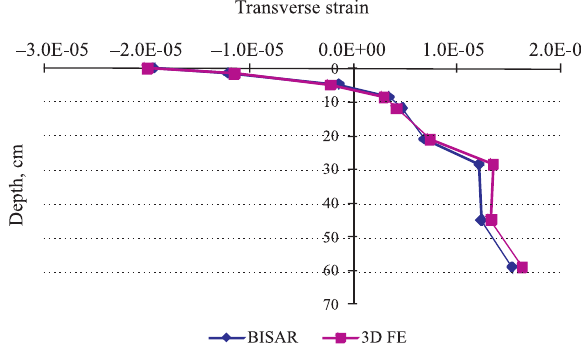
Fig. 3. Tire contact stress in vertical direction: a – original data; Fig. 4. Validation of the 3D